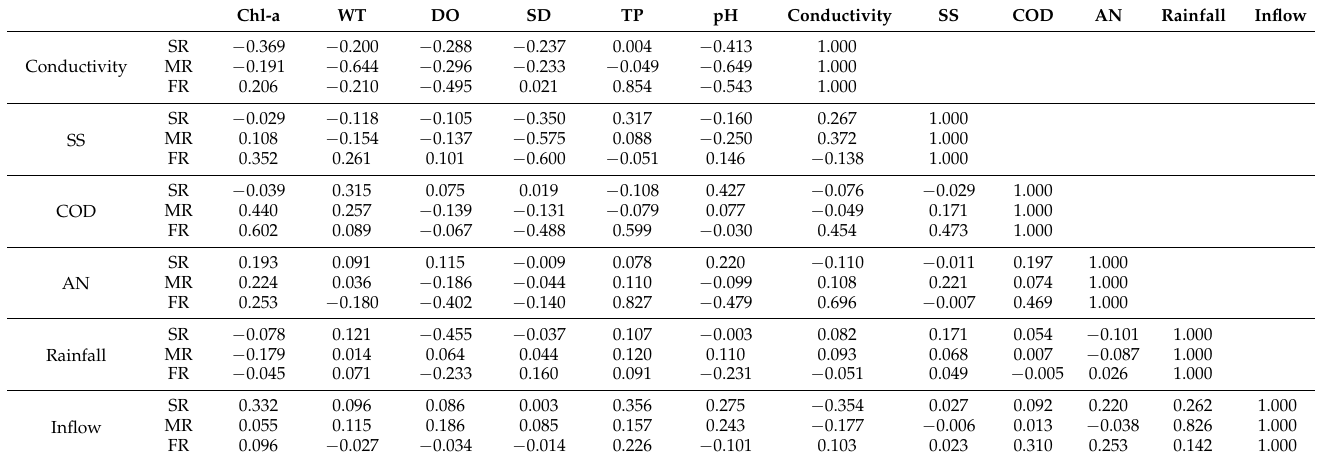
Table 4. Correlation coefficients between factors from correlation analyses